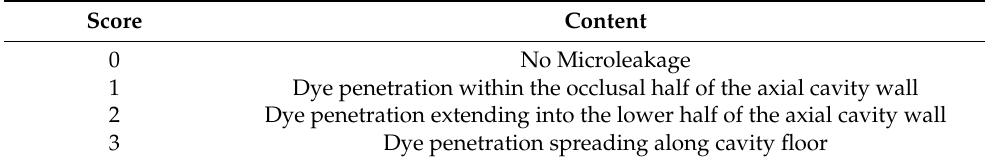
Table 3. Four grade scale showing degree of